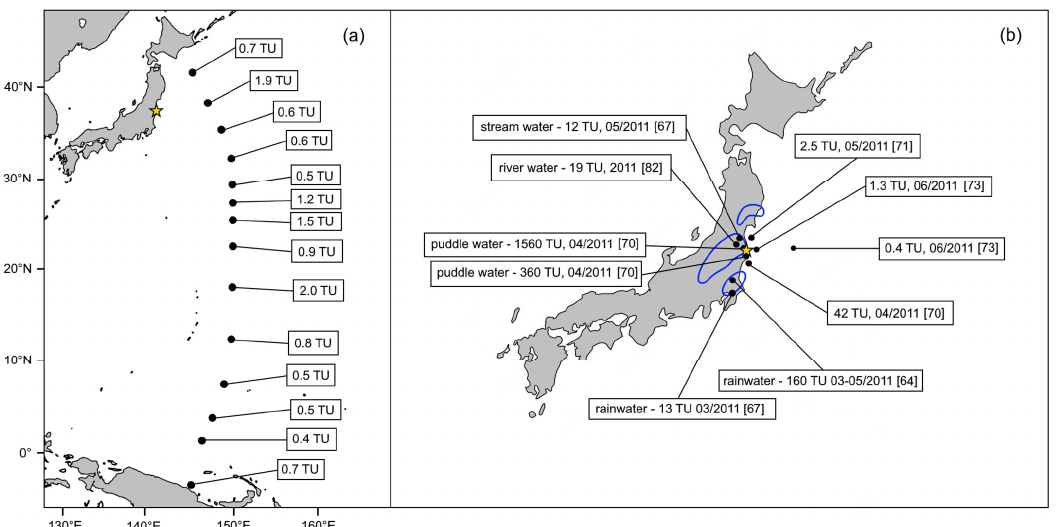
Figure 2. Tritium activity concentrations in various water samples after the FDNPP accident: ( a ) surface seawater values of the western North Pacific Ocean in winter 2012 according to [68], and ( b ) selected 2011 samples from Japan, given with the date of their collection and respective reference [64,67,69–72]. The yellow star represents the location of the FDNPP. The blue lines show the approximate areas of the significant wet deposition during the second half of March 2011 [2].